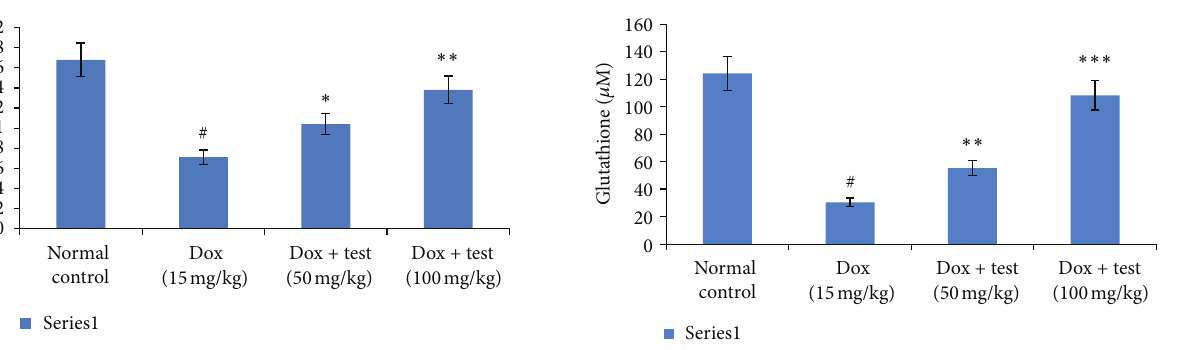
Figure 7: Effect of test compound on glutathione levels in plasma in rats treated with doxorubicin. # 𝑃 < 0.001 versus normal control; ∗∗ 𝑃 < 0.01 versus dox; ∗ 𝑃 < 0.001 versus dox. In this study, we found that single dose of doxorubicin to rats causes significant ( 𝑃 < 0.001 ) decrease in glutathione levels. This reduction indicates that toxicity is produced with doxorubicin. Pretreatment with test compound at the doses of 50 mg/kg and 100 mg/kg before a single dose of doxorubicin administration showed a significant ( 𝑃 < 0.01 and 𝑃 < 0.001 ) dose dependent increase in levels compared to doxorubicin